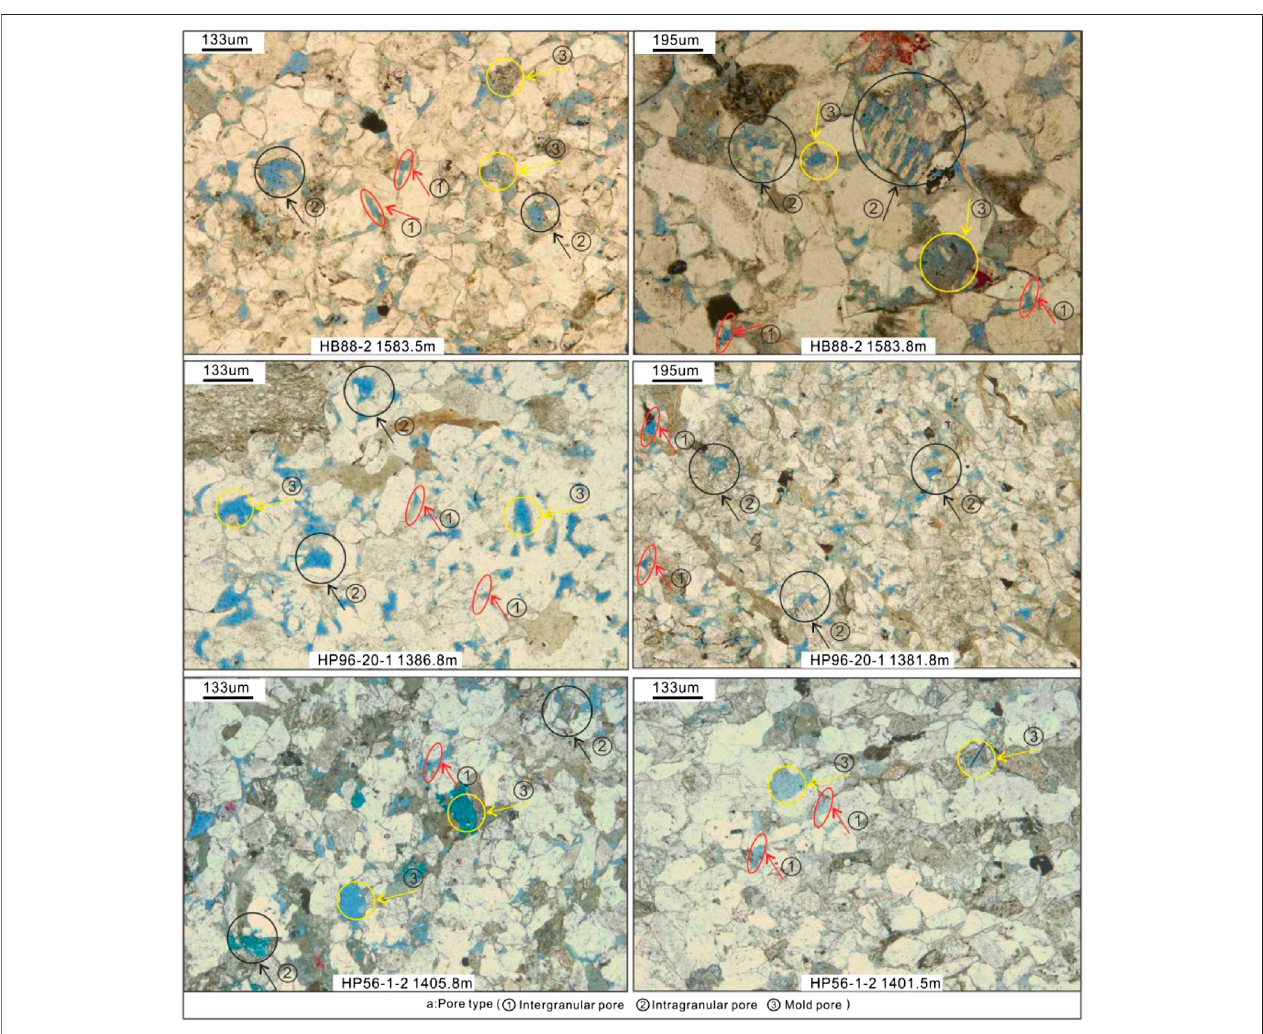
FIGURE 11 | The different pore types of the sandstone ( ① intergranular pores; ② dissolution pore of feldspar; and ③ mold pore of the debris dissolution).